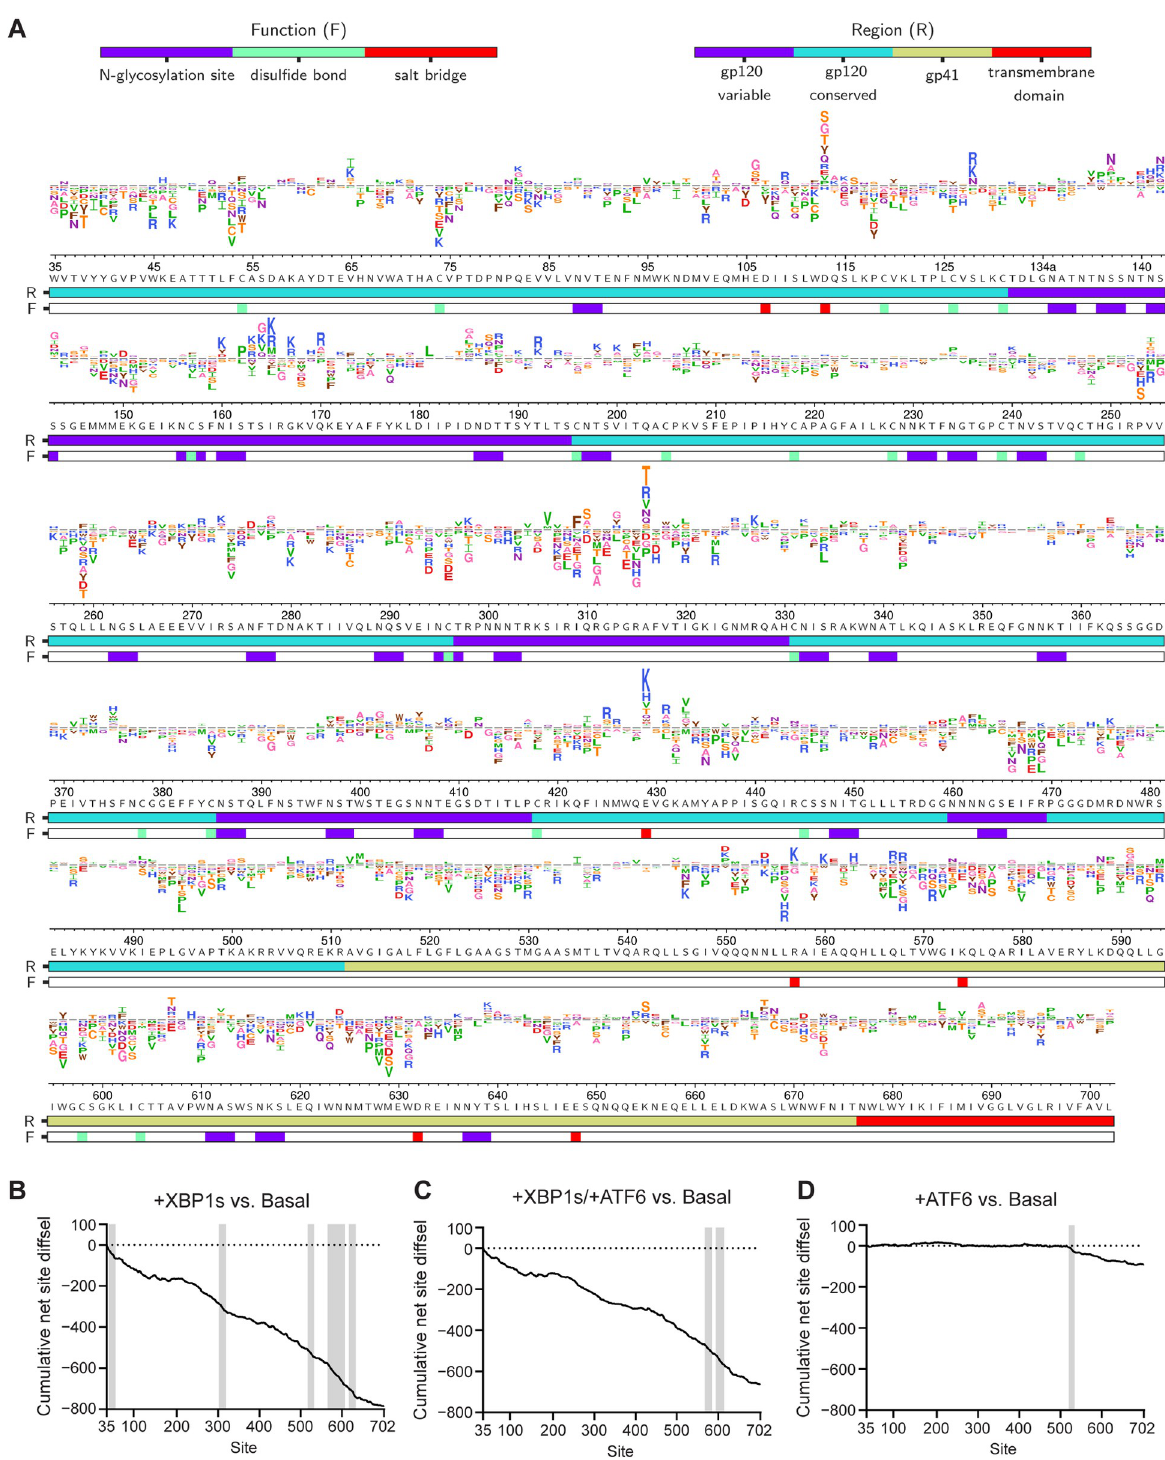
Fig 4. Differential selection (diffsel) across Env upon remodeling of the host’s endoplasmic reticulum proteostasis network. (A) Logo plot displaying averaged diffsel for +XBP1s normalized to the basal proteostasis environment. The height of the amino acid abbreviation is proportional to the magnitude of diffsel. The amino acid abbreviations are colored based on their side-chain properties: negatively charged (D, E; red), positively charged (H, K R; blue), polar uncharged (C, S, T; orange/N, Q; purple), small nonpolar (A, G; pink), aliphatic (I, L, M, P, V; green), and aromatic (F, W, Y; brown). The numbers and letters below the logos indicate the Env site in HXB2 numbering and the identity of the wild-